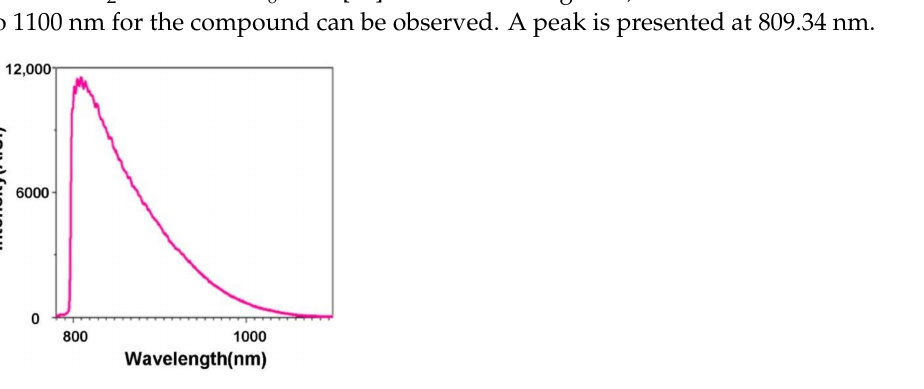
Figure 4. NIR fluorescence of Ho-oxide compound (excitation wavelength = 785 nm).